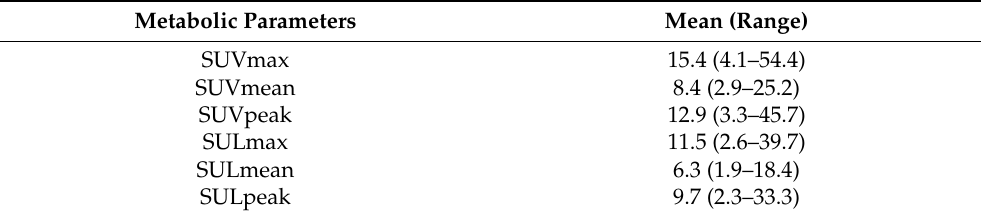
Table 2. SUV parameters of the primary tumor. Metabolic